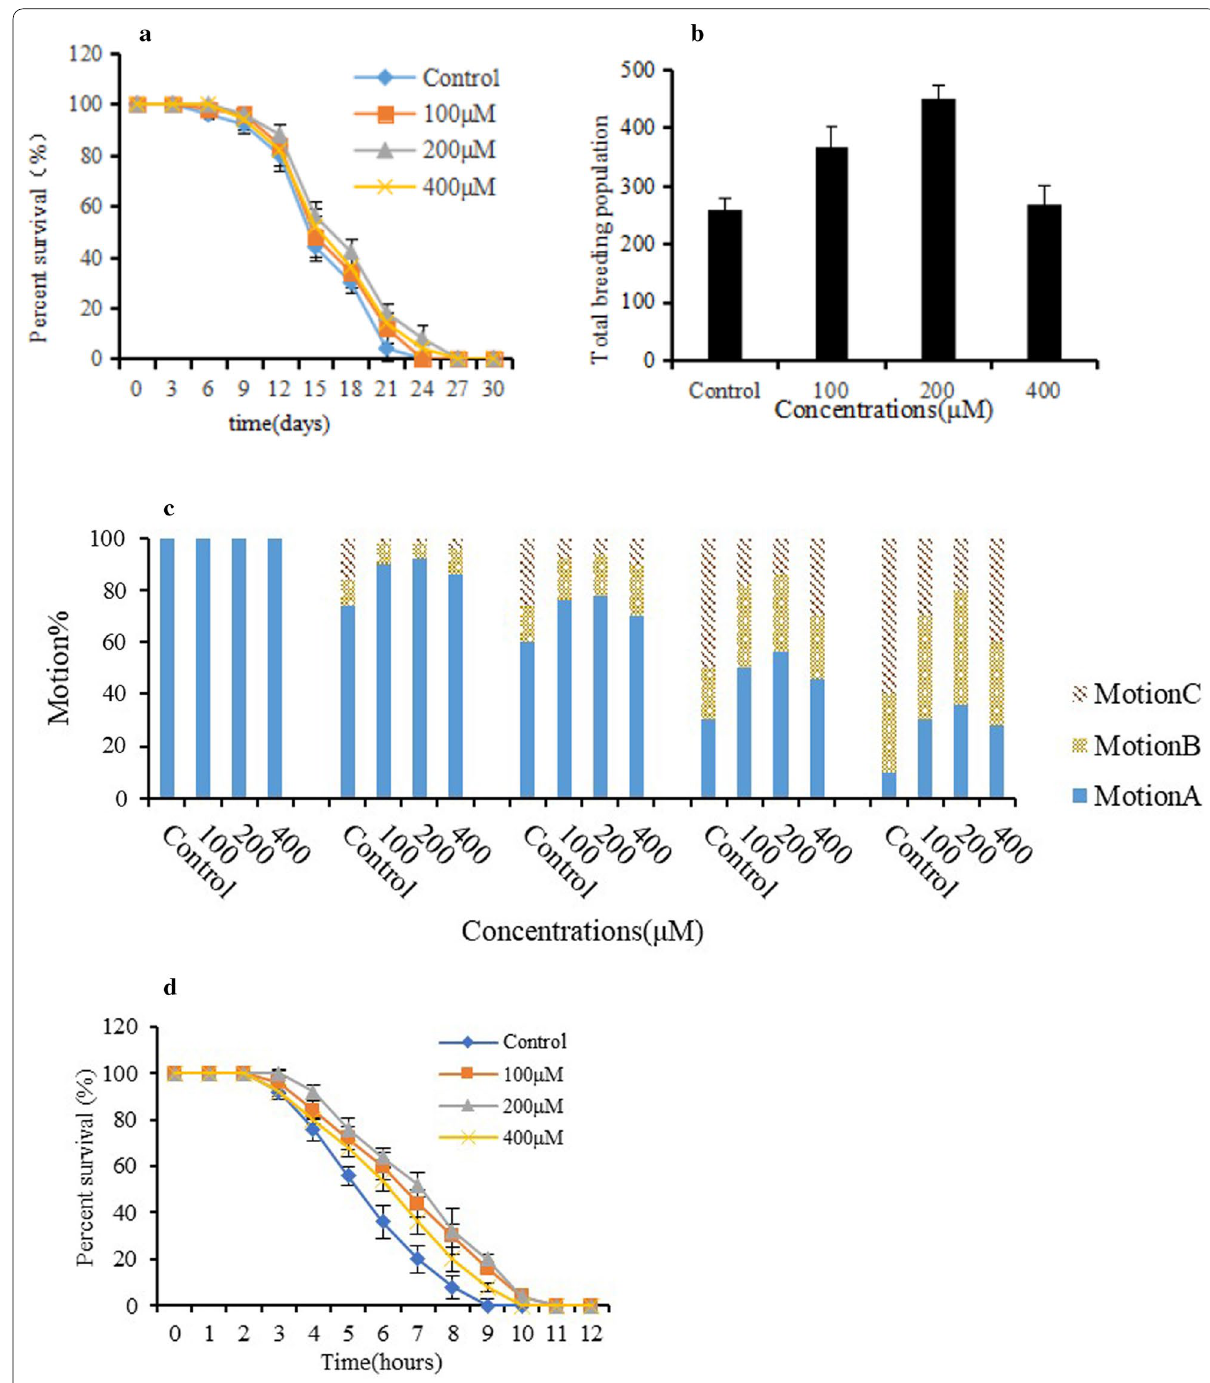
Fig. 4 Antiaging activities of compound 11. a Effect of compound 11 on lifespan of C. elegans (Control, equal volume solvent). b Effect of compound 11 on reproduction of C. elegans (Control, equal volume solvent). c Effect of compound 11 on locomotion (Control, equal volume solvent). d Effect of compound 11 on heat stress tolerance of C. elegans (Control, equal volume